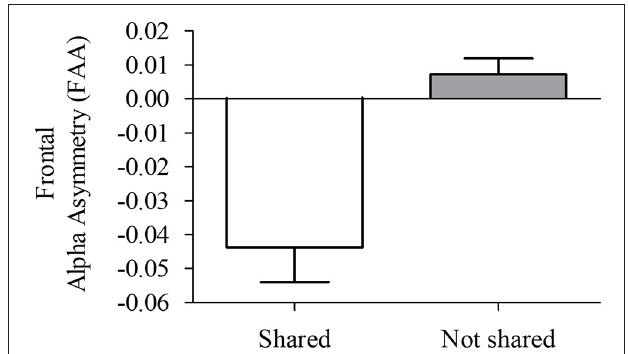
FIGURE 4 | Frontal alpha asymmetry (FAA) index (lnPSD F4 − lnPSD F3) during viewing of S and N-S videos. Data are presented as the mean ± SEM ( t = 4.95, p = 0.002). More negative FAA values reflect higher alpha activation in the right hemisphere when compared with the left hemisphere.